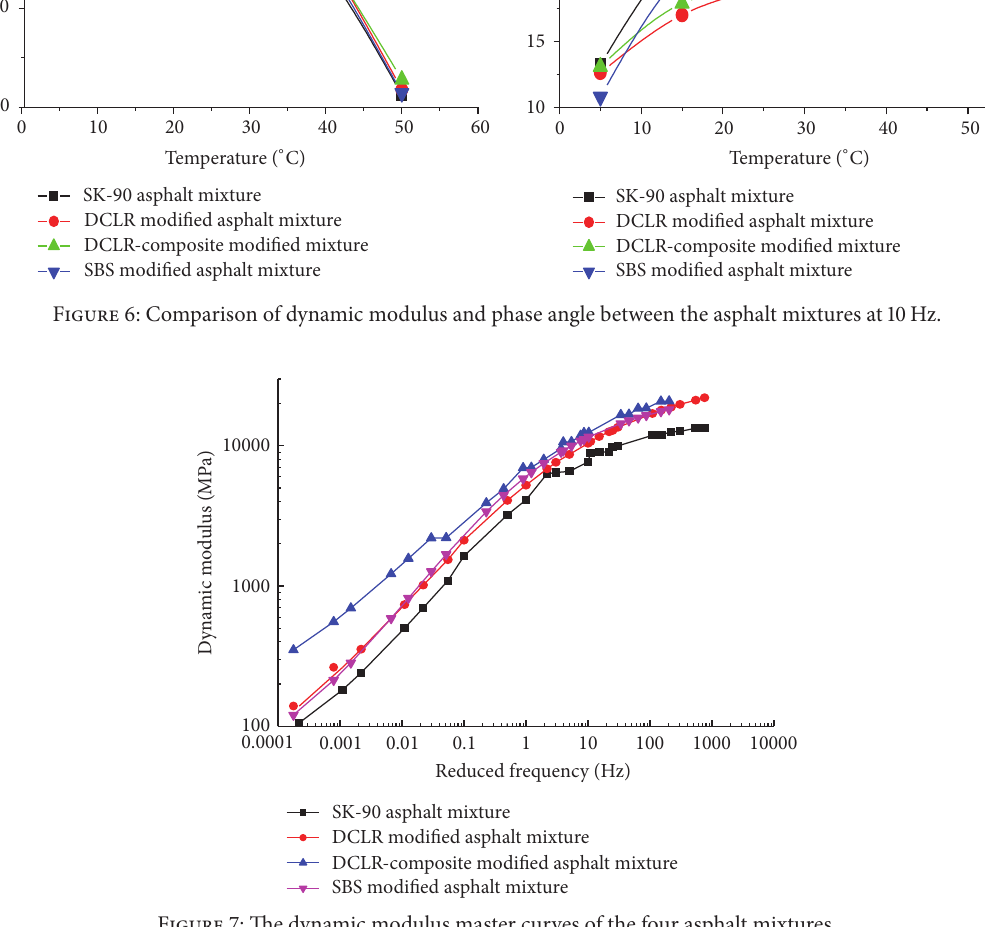
Figure 7: The dynamic modulus master curves of the four asphalt